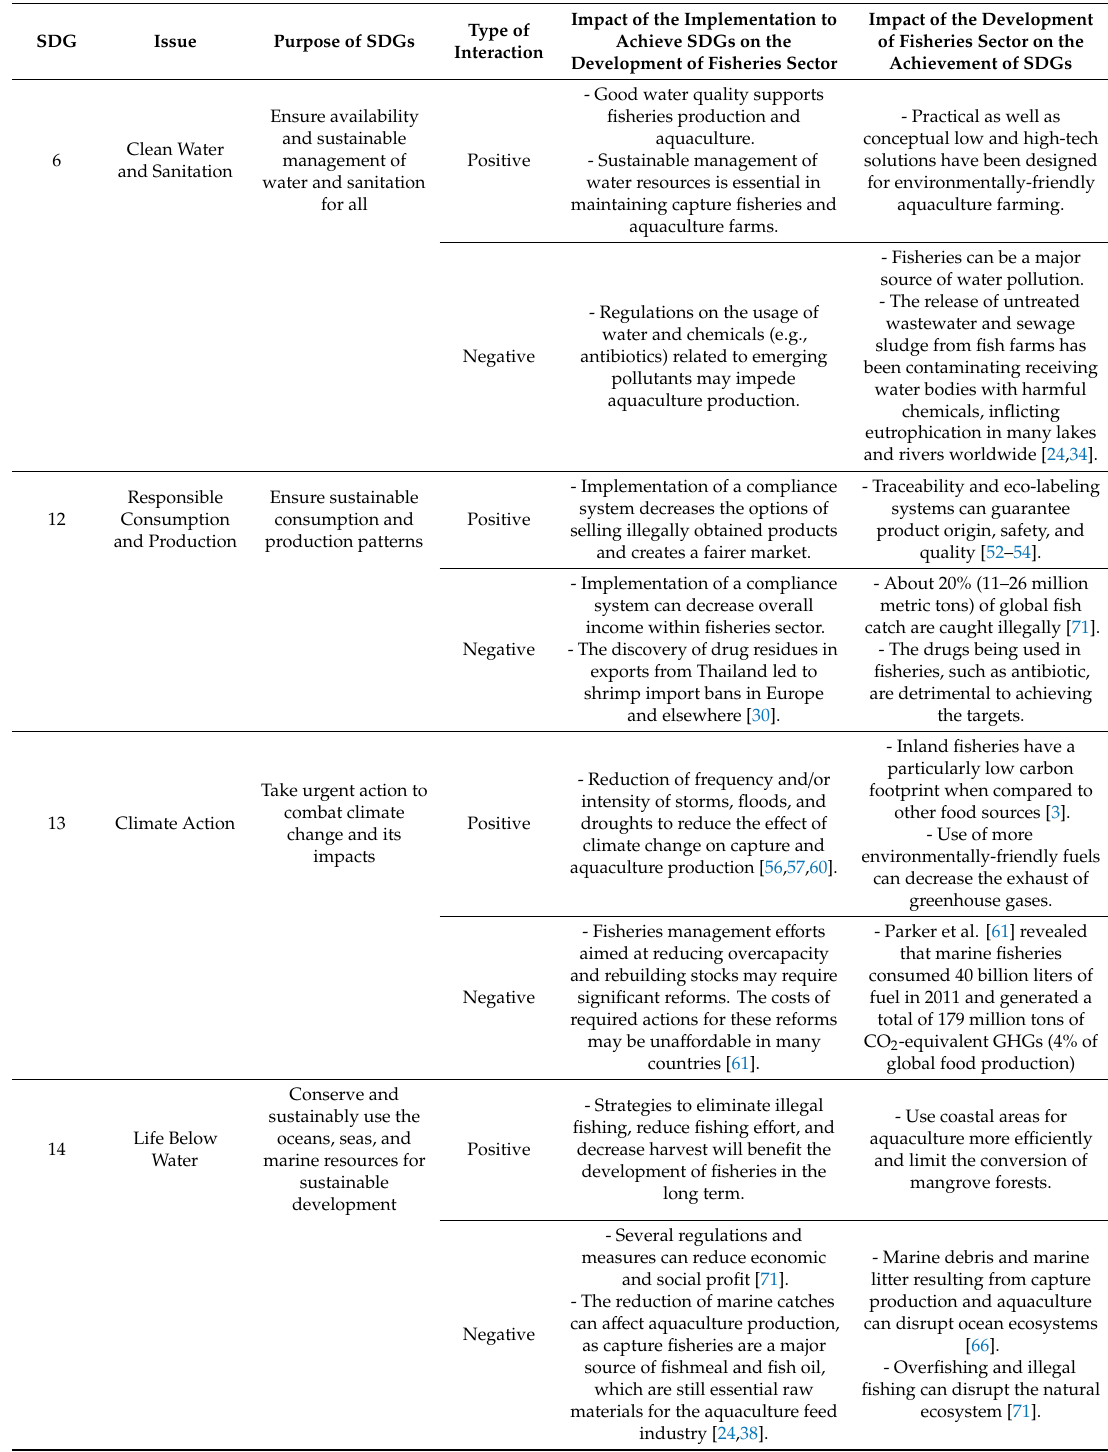
Table 2. An overview of the interactions between planet-based SDGs and the fisheries